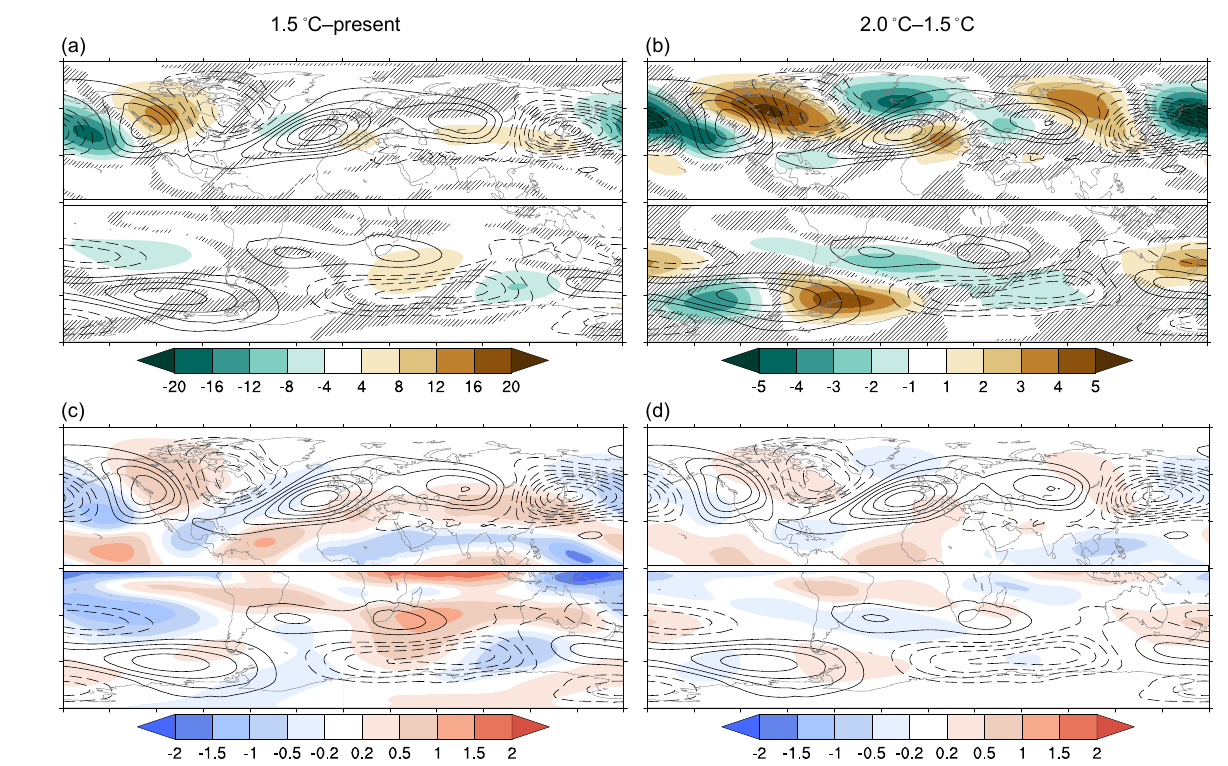
Figure 10. Multi-model mean response of winter (Northern Hemisphere DJF, Southern Hemisphere JJA) stationary waves at 500hPa for 1.5 ◦ C–PD (a, c) and 2.0–1.5 ◦ C (b, d) . Panels (a) and (b) show responses (shading; units m) along with the climatology (contour interval 25m) for the (a) PD and (b) 1.5 ◦ C experiments. Note the different colour scale for (a) and (b) . Panels (c) and (d) show signal-to-noise ratio β/σ , where the sign corresponds to the sign of the response, along with the climatology (contour interval 25m) for the (c) 1.5 ◦ C and (d) 2.0 ◦ C experiments. In (a) and (b) , hatching masks out regions where there is no model consensus (fewer than four out of five models agree) on the sign of the response. In (c) and (d) , black dots mask out regions where the models do not agree on the magnitude of the response ( f 2 > 1). Stationary waves are defined as departures from the zonal mean of geopotential height ( Z ∗ ) at